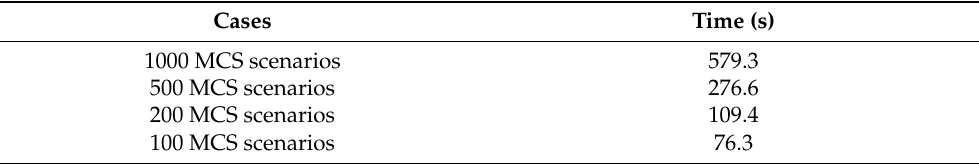
Table 6. Computational Performance of the Proposed Model for Day-ahead